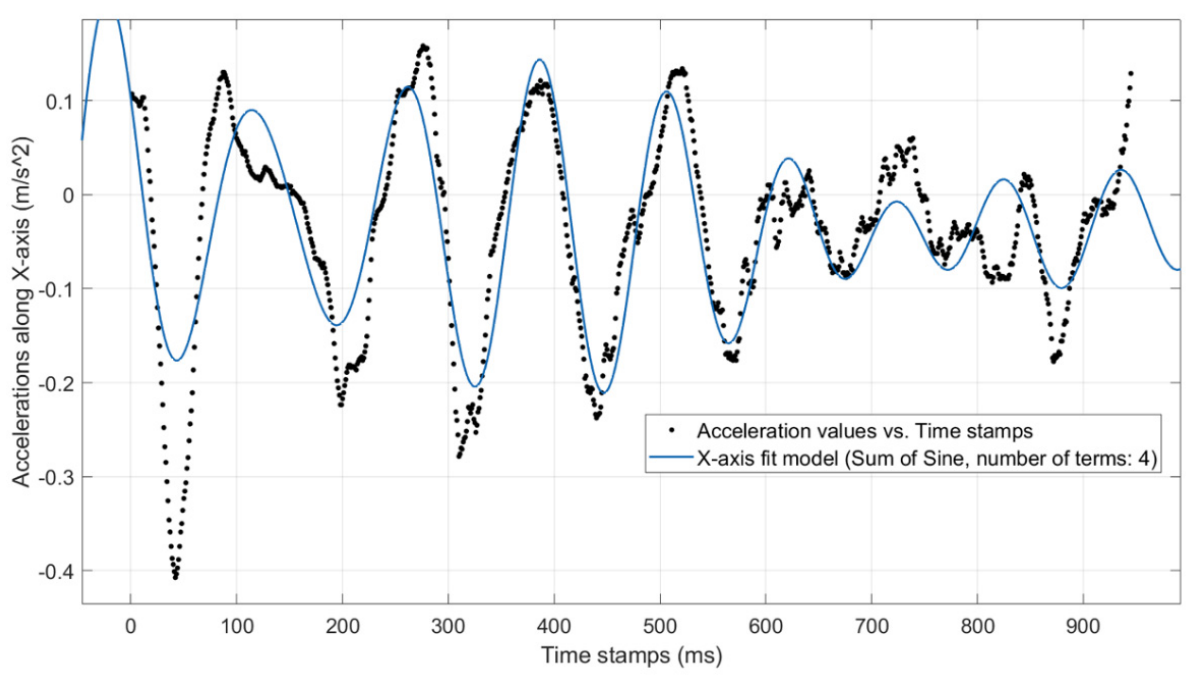
Figure 7. Acquired acceleration values from one of the handling